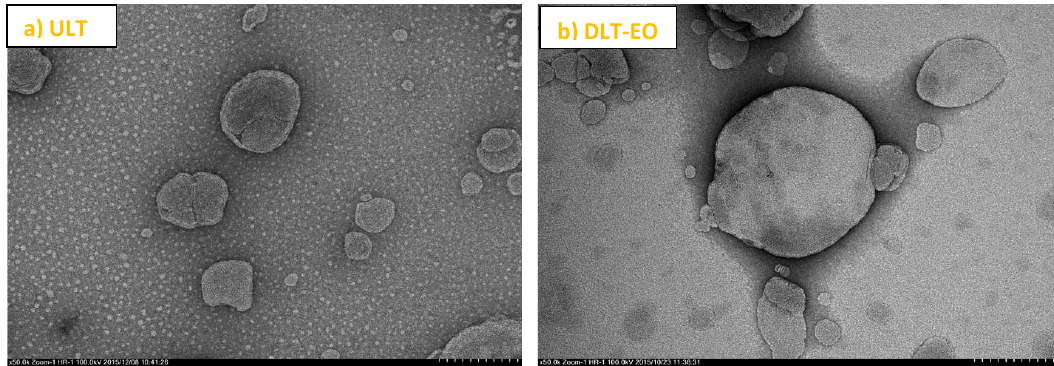
Figure 1. TEM images of transfersomes prepared in this study. The images approximately Figure 1 : TEM images of Transfersomes prepared in this study. The images approximately represented the represented the morphology of spherical liposome vesicles. ( a ) ULT—unloaded transfersomes; morphology of spherical liposome vesicles. (a) ULT: unloaded transfersomes; (b) DLT-EO: drug loaded and ( b ) DLT–EO—drug loaded transfersomes with emu oil at magnifications of × 50.0 k. (adapted transfersomes with emu oil. (Adapted from from